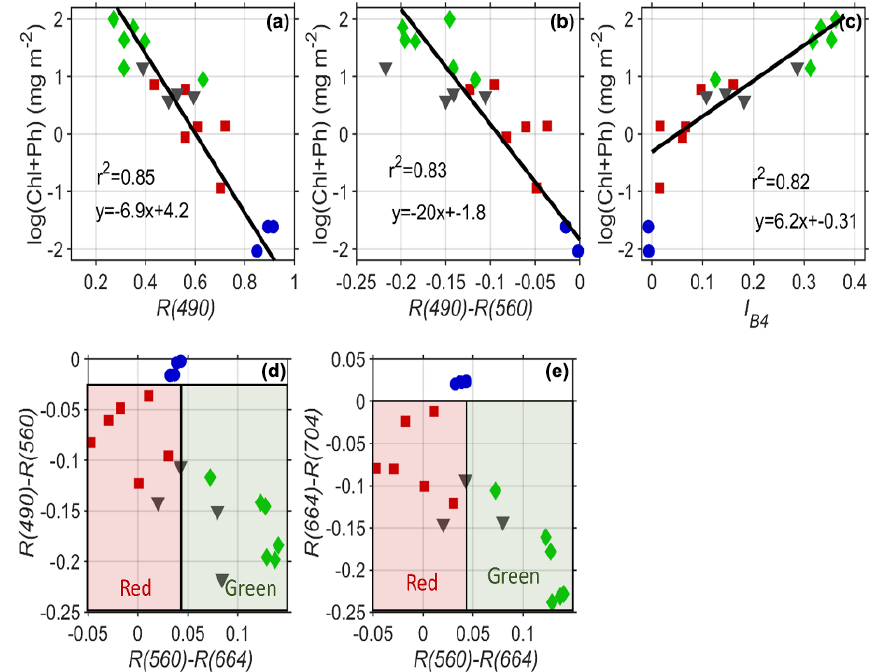
Figure 7. (a) The reflectance in blue wavelengths (490nm) is inversely correlated to the logarithmic concentration of pigment. (b) The difference in blue to green bands from Sentinel-2 explains 83% of the variability in pigment and can be used for remote sensing of pigment. (c) The scaled integral in Sentinel-2 Band 4 (660nm) is related to pigment concentrations for indices > 0. Red and green algae can be differentiated easily based on their differential absorption in green wavelengths 560nm compared to (d) red and blue bands and (e) red and infrared bands. Red squares are red algae; green diamonds are green algae; black triangles are mixtures of the two; blue circles are clean